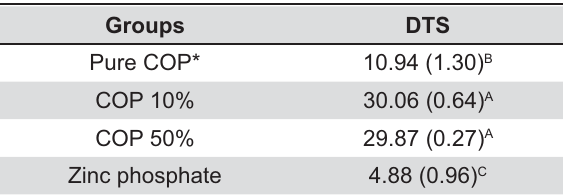
Table 1- Diametral tensile strength (MPa) of dental luting agents and standard deviations